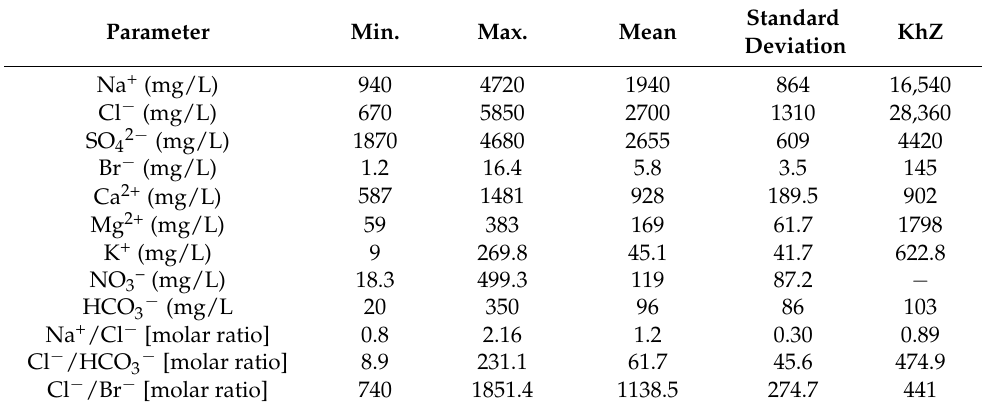
Table 1. Statistical summary of some groundwater constituents and chemical relationships of 39 groundwater samples, and the relevant values in Khor Al-Zubair (KhZ).